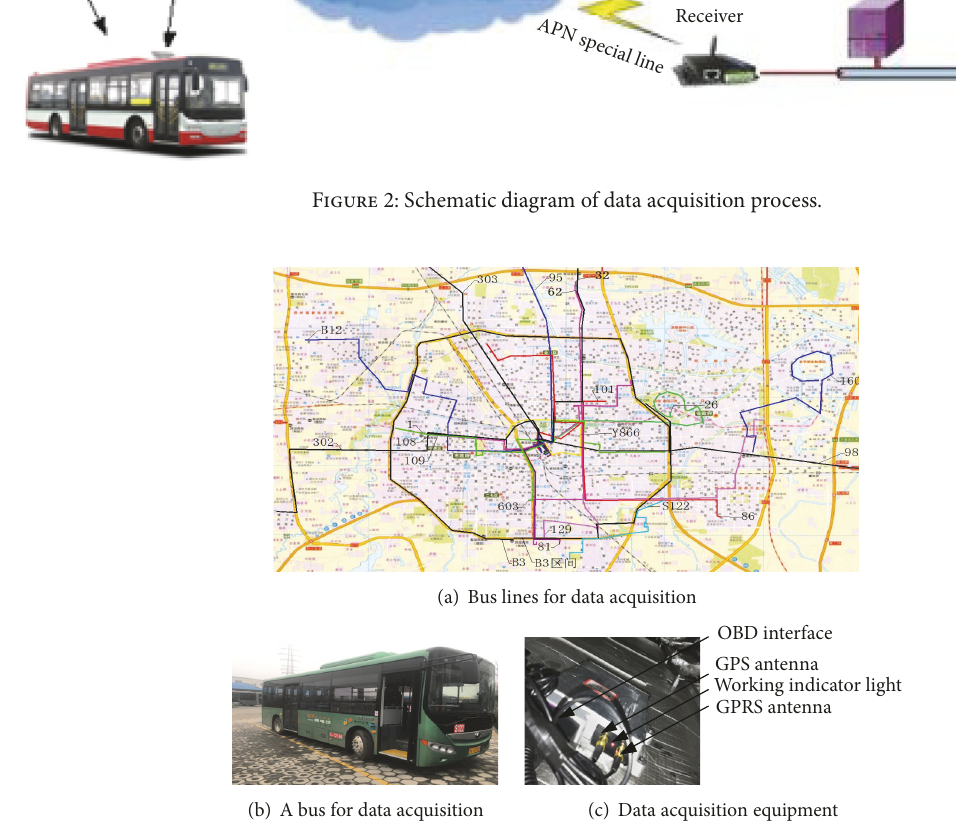
Figure 3: Routes, bus, and equipment for data